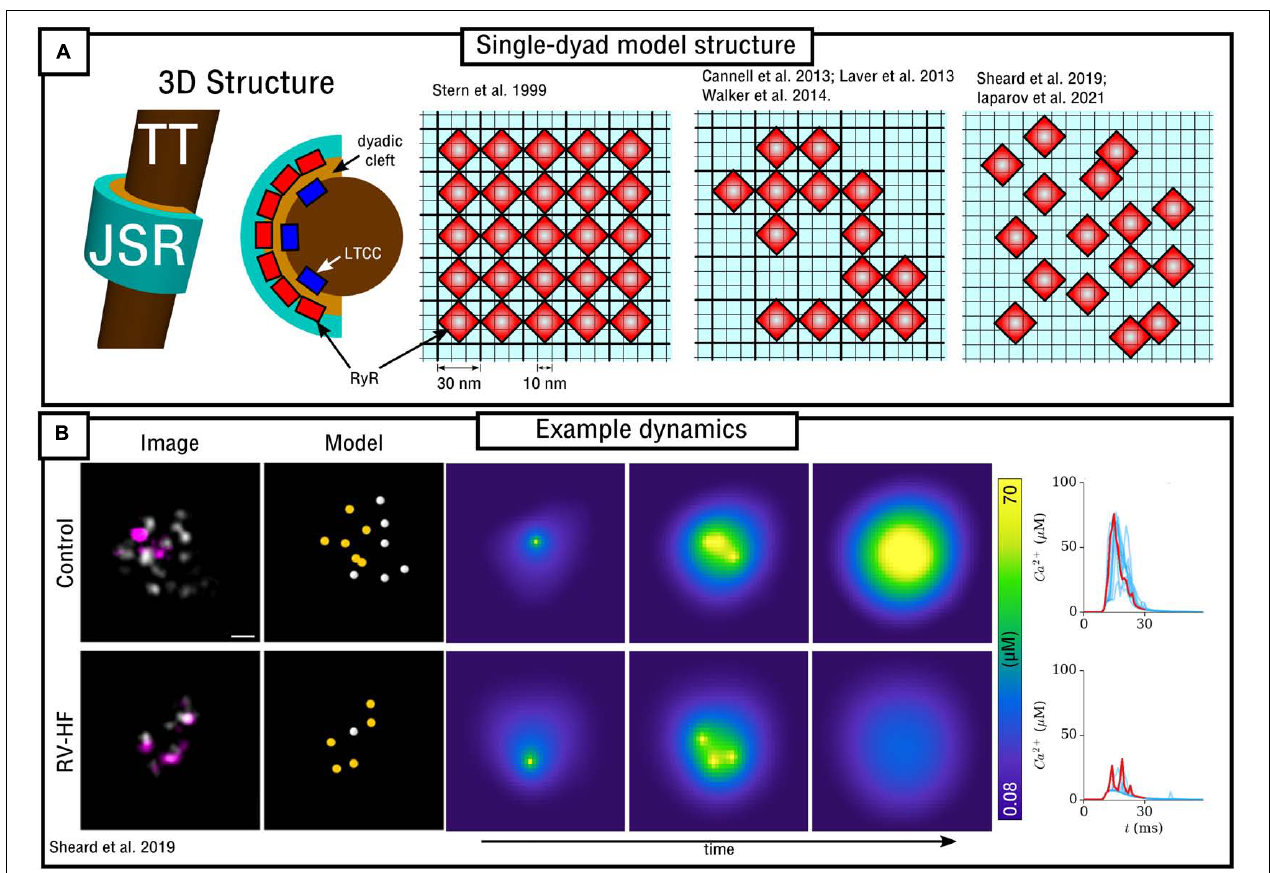
FIGURE 4 | Spatial models of the dyad. (A) Illustration of model structure (left) and different approaches to RyR arrangement (right), ranging from regular lattice through irregular lattice to free-placement. (B) Illustration of a triggered Ca 2 + spark occurring in two different RyR arrangements, corresponding to control and right-ventricular heart failure (RV-HF) directly reconstructed from imaging data. Scale bar corresponds to 50 nm. Reproduced with data from Sheard et al.